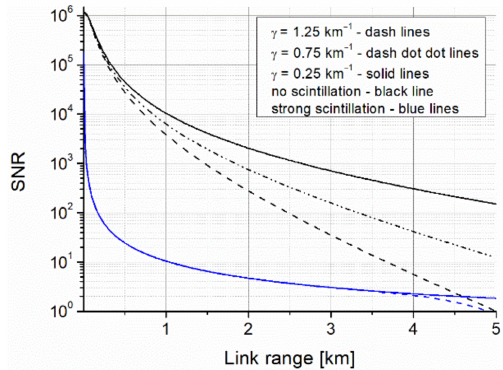
Figure 6. SNR values versus link range.